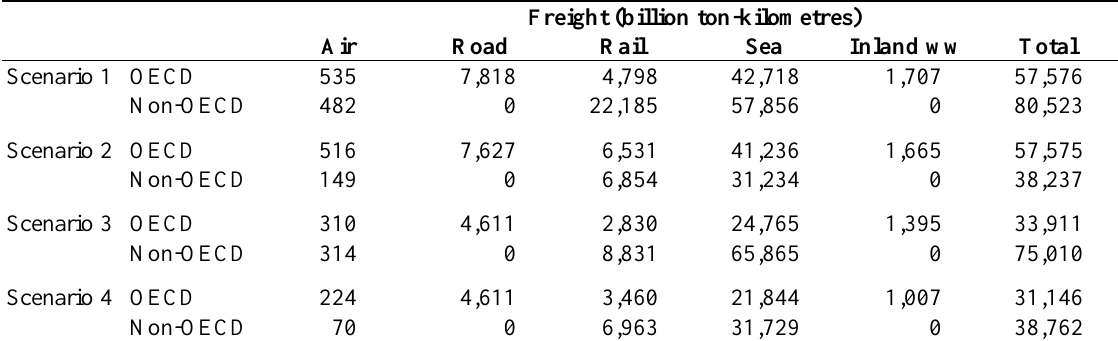
Table 15. Estimated volumes for freight transport (2020)